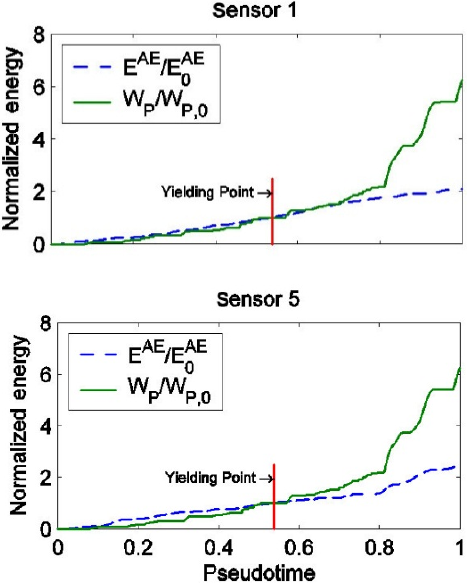
Figure 14. Accumulated AE energy (dashed line) and accumulated hysteretic strain energy (solid line). Beam-column connection.